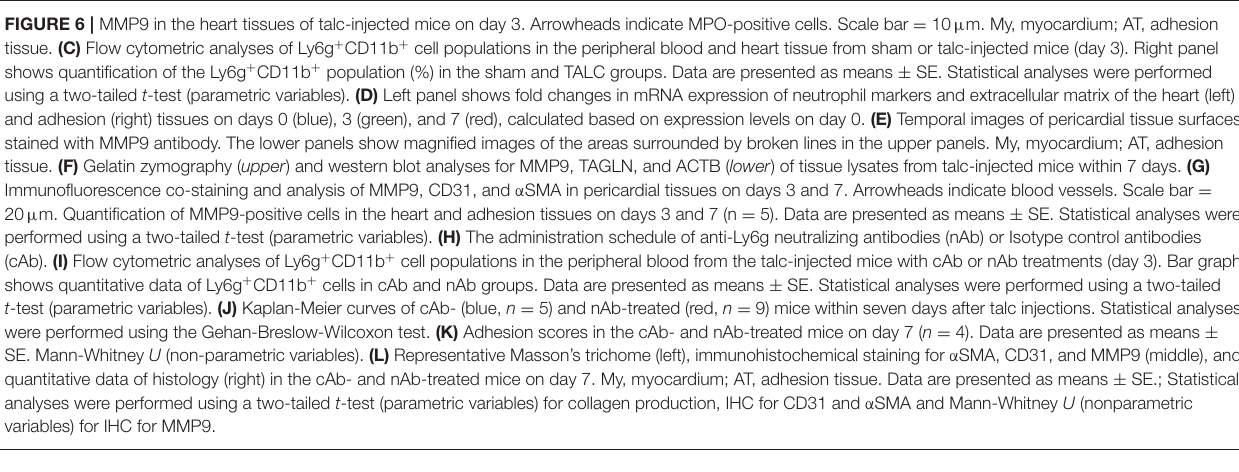
FIGURE 6 | MMP9 in the heart tissues of talc-injected mice on day 3. Arrowheads indicate MPO-positive cells. Scale bar = 10 µ m. My, myocardium; AT, adhesion tissue. (C) Flow cytometric analyses of Ly6g + CD11b + cell populations in the peripheral blood and heart tissue from sham or talc-injected mice (day 3). Right panel shows quantification of the Ly6g + CD11b + population (%) in the sham and TALC groups. Data are presented as means ± SE. Statistical analyses were performed using a two-tailed t -test (parametric variables). (D) Left panel shows fold changes in mRNA expression of neutrophil markers and extracellular matrix of the heart (left) and adhesion (right) tissues on days 0 (blue), 3 (green), and 7 (red), calculated based on expression levels on day 0. (E) Temporal images of pericardial tissue surfaces stained with MMP9 antibody. The lower panels show magnified images of the areas surrounded by broken lines in the upper panels. My, myocardium; AT, adhesion tissue. (F) Gelatin zymography ( upper ) and western blot analyses for MMP9, TAGLN, and ACTB ( lower ) of tissue lysates from talc-injected mice within 7 days. (G) Immunofluorescence co-staining and analysis of MMP9, CD31, and α SMA in pericardial tissues on days 3 and 7. Arrowheads indicate blood vessels. Scale bar = 20 µ m. Quantification of MMP9-positive cells in the heart and adhesion tissues on days 3 and 7 (n = 5). Data are presented as means ± SE. Statistical analyses were performed using a two-tailed t -test (parametric variables). (H) The administration schedule of anti-Ly6g neutralizing antibodies (nAb) or Isotype control antibodies (cAb). (I) Flow cytometric analyses of Ly6g + CD11b + cell populations in the peripheral blood from the talc-injected mice with cAb or nAb treatments (day 3). Bar graph shows quantitative data of Ly6g + CD11b + cells in cAb and nAb groups. Data are presented as means ± SE. Statistical analyses were performed using a two-tailed t -test (parametric variables). (J) Kaplan-Meier curves of cAb- (blue, n = 5) and nAb-treated (red, n = 9) mice within seven days after talc injections. Statistical analyses were performed using the Gehan-Breslow-Wilcoxon test. (K) Adhesion scores in the cAb- and nAb-treated mice on day 7 ( n = 4). Data are presented as means ± SE. Mann-Whitney U (non-parametric variables). (L) Representative Masson’s trichome (left), immunohistochemical staining for α SMA, CD31, and MMP9 (middle), and quantitative data of histology (right) in the cAb- and nAb-treated mice on day 7. My, myocardium; AT, adhesion tissue. Data are presented as means ± SE.; Statistical analyses were performed using a two-tailed t -test (parametric variables) for collagen production, IHC for CD31 and α SMA and Mann-Whitney U (nonparametric variables) for IHC for